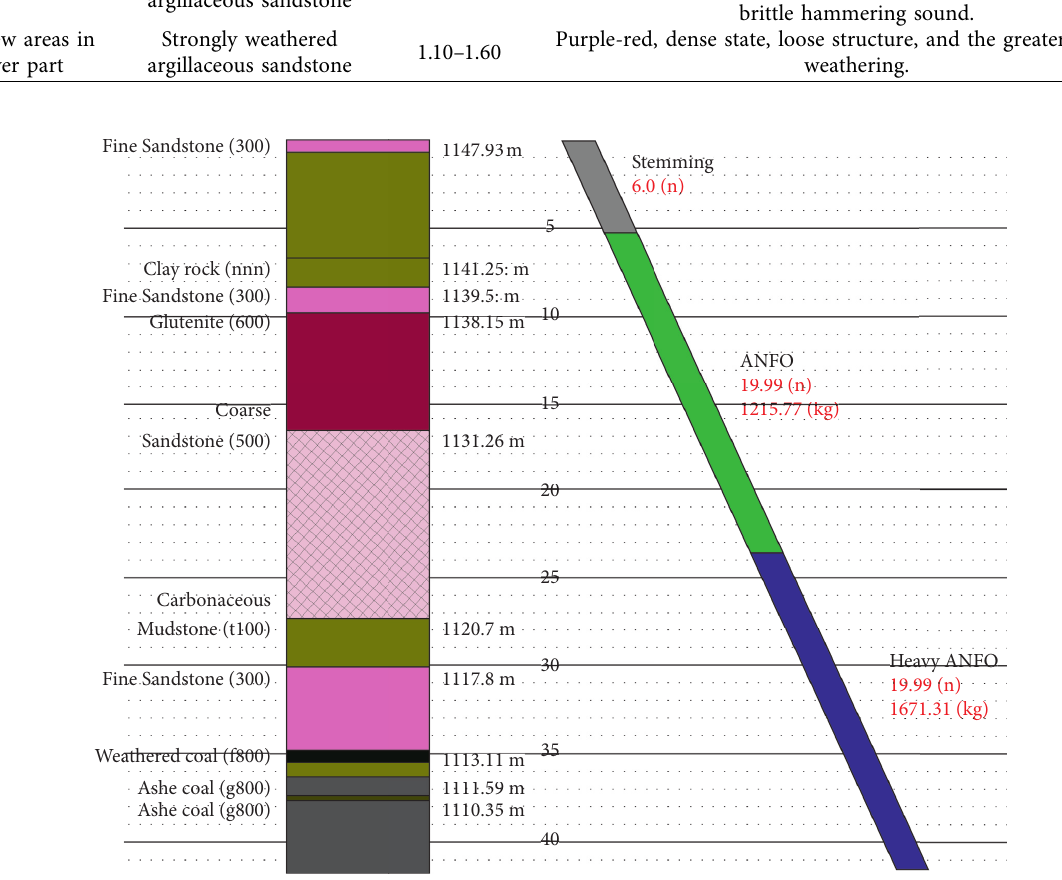
Figure 1: Geologic information near the blast hole.